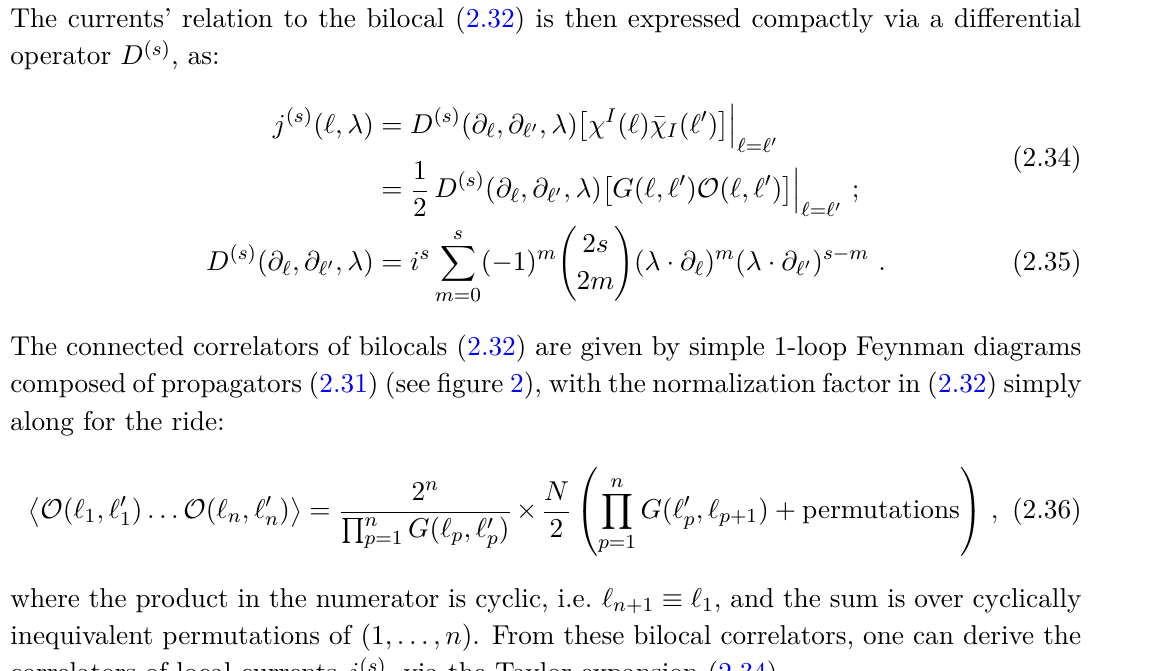
Figure 2 . Boundary Feynman diagram for a quartic correlator of bilocals O ( ‘ i , ‘ 0 of view of the operator O ( ‘ bilocal, in this case as O ( ‘